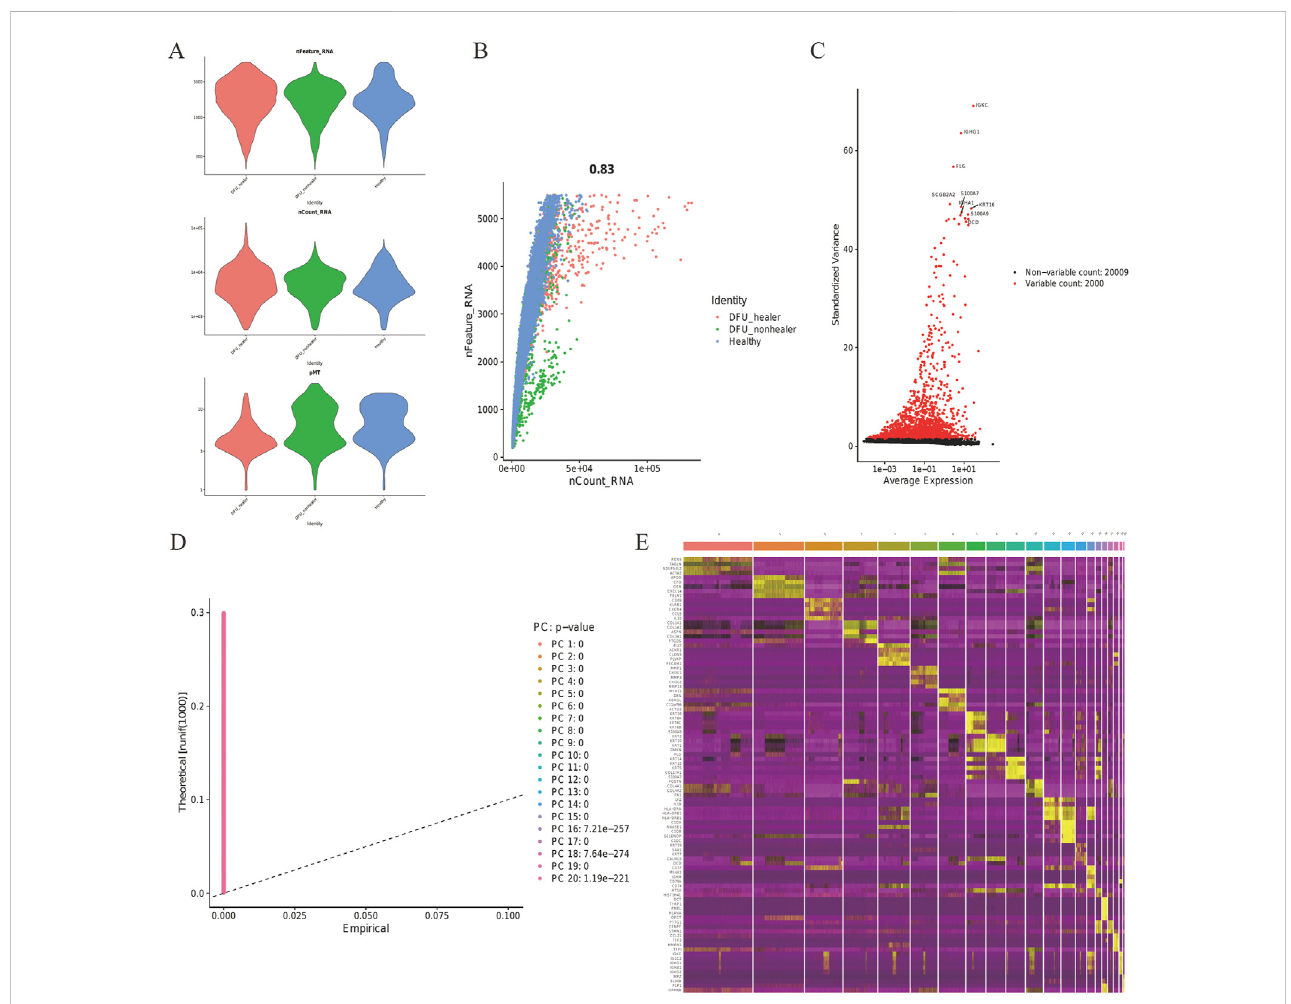
FIGURE 1 Skin tissue in DFUs was analyzed using scRNA. (A) Every specimen ’ s genes (features), numbers, and percentage of mitochondrial genes. (B) Correlation between thegenesandcounts for everyspecimen. (C) Top 10HVGswereidenti fi ed,andHVGsare colored inred. (D) JackStrawfunction selectionofPCs. (E) Heatmap showing the top 10 DEGs within every cluster. Yellow labels are used to identify the top 10